Question: What type of chart is this?
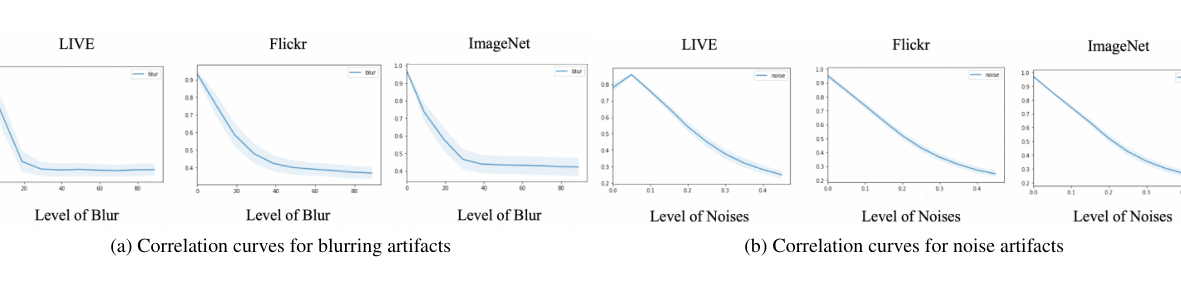
Answer: line